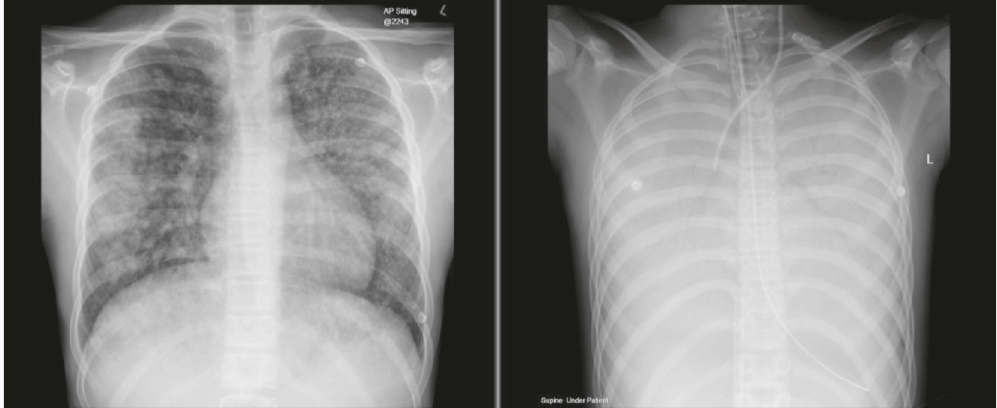
Figure 1: Early and late chest radiograph’s demonstrating pulmonary